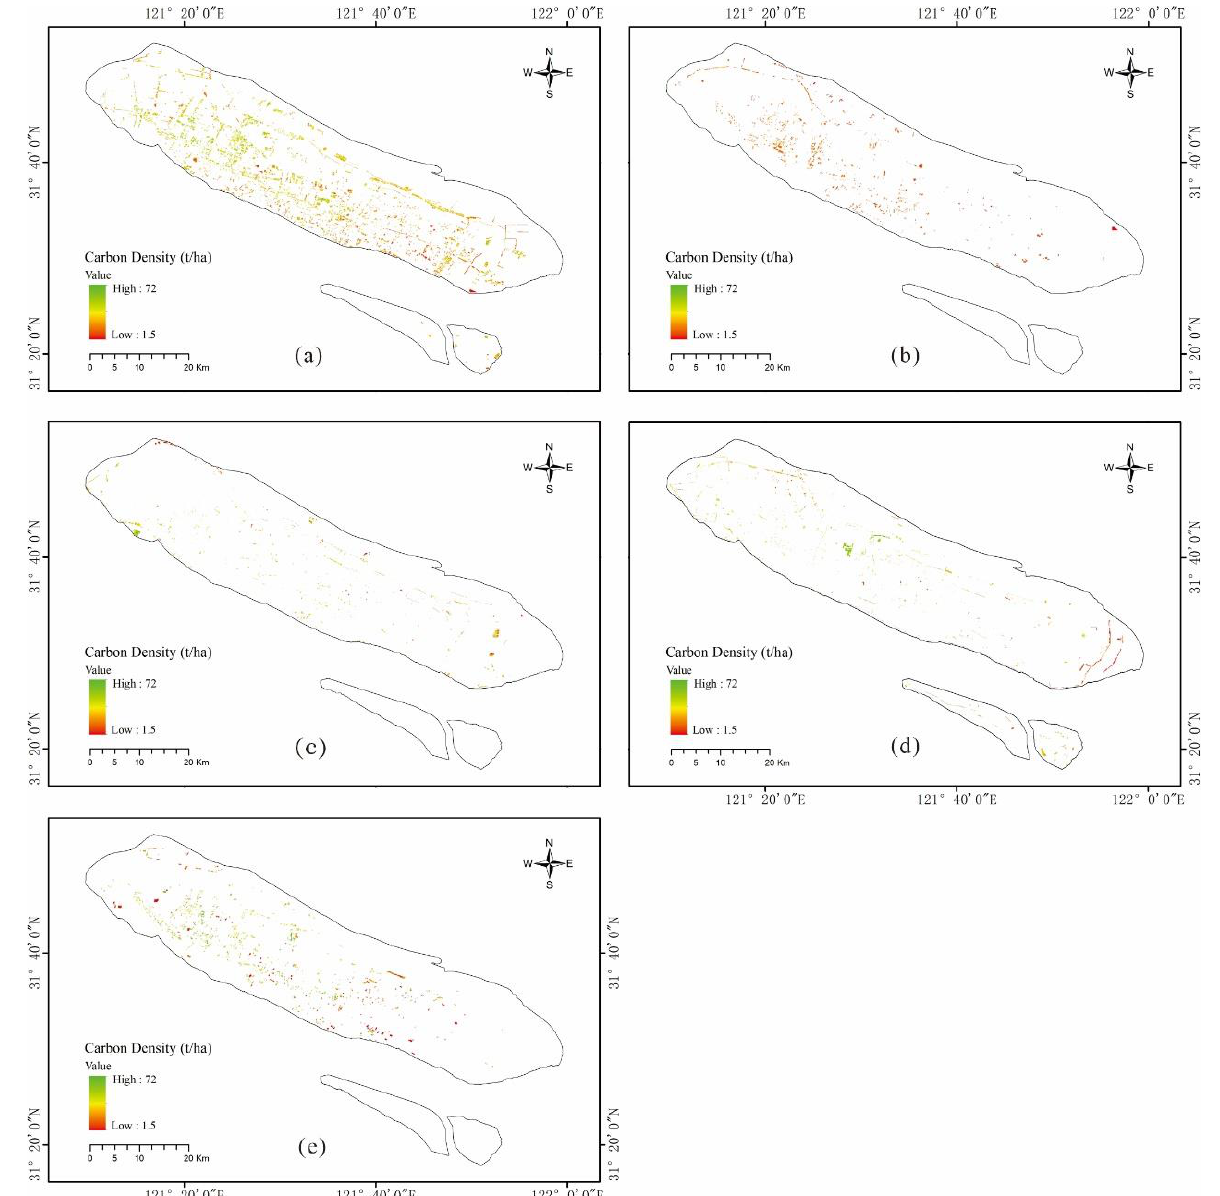
Figure 5. Spatial distribution of the forest carbon density by dominant tree species on Chongming eco-island: ( a ) C. camphora , ( b ) L. lucidum , ( c ) T. distichum var. imirricatum , ( d ) M. glyptostroboides , and ( e ) S. saponaria .